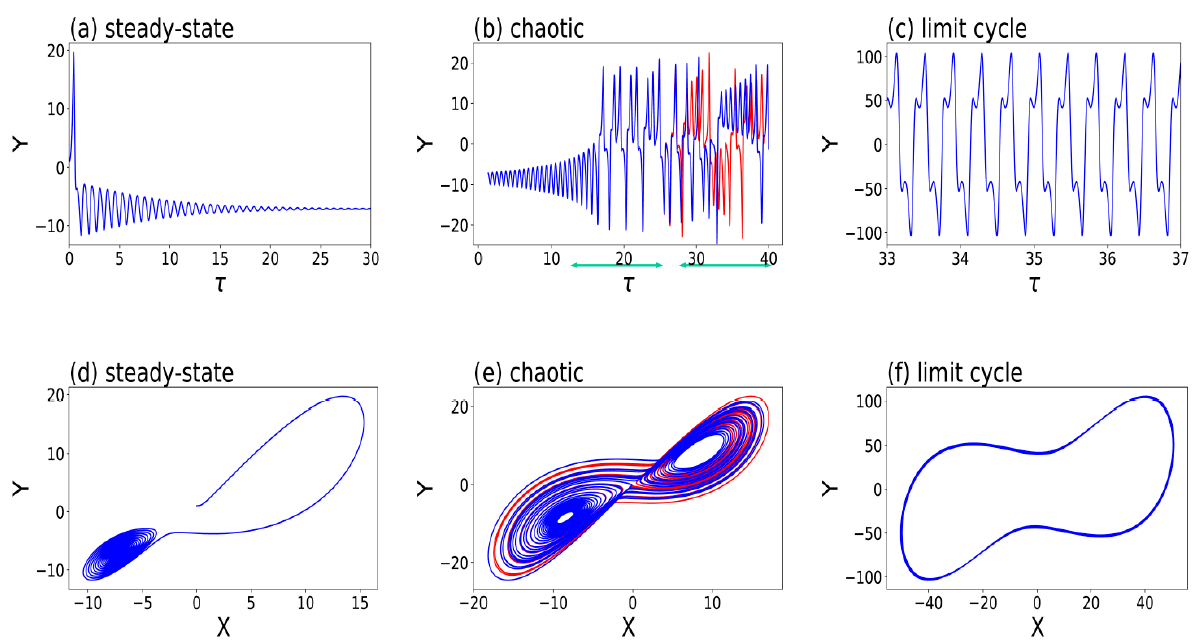
Figure 2. Three types of solutions within the Lorenz 1963 model. Steady-state (a,d), chaotic (b,e), and limit cycle (c,f) solutions appear at small, moderate, and large normalized Rayleigh parameters (i.e., r = 20, 28, and 350), respectively. Control and parallel runs are shown in red and blue, respec- tively. SDIC is indicated by visible blue and red curves in panel ( b ), where the first and second green horizonal lines indicate CDIC and SDIC, respectively. ( a – c ) depict the time evolution of Y. ( d – f ) show orbits within the X – Y space, appearing as a point attractor ( a , d ), a chaotic attractor ( b , e ), and a periodic attractor ( c , f ), respectively (after Shen et al., 2021 [10]). The other two parameters are kept as constants: σ = 10 and b = 8/3. The initial conditions of (𝑋, 𝑌, 𝑍) for the control and parallel runs are (0,1,0) and (0,1 + 𝜖 ,0), respectively.